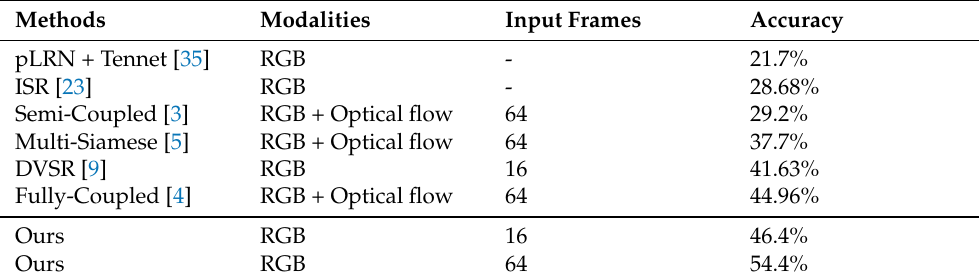
Table 4. The performance of the proposed method and other state-of-the-art methods on the 12 × 16 HMDB51 dataset.